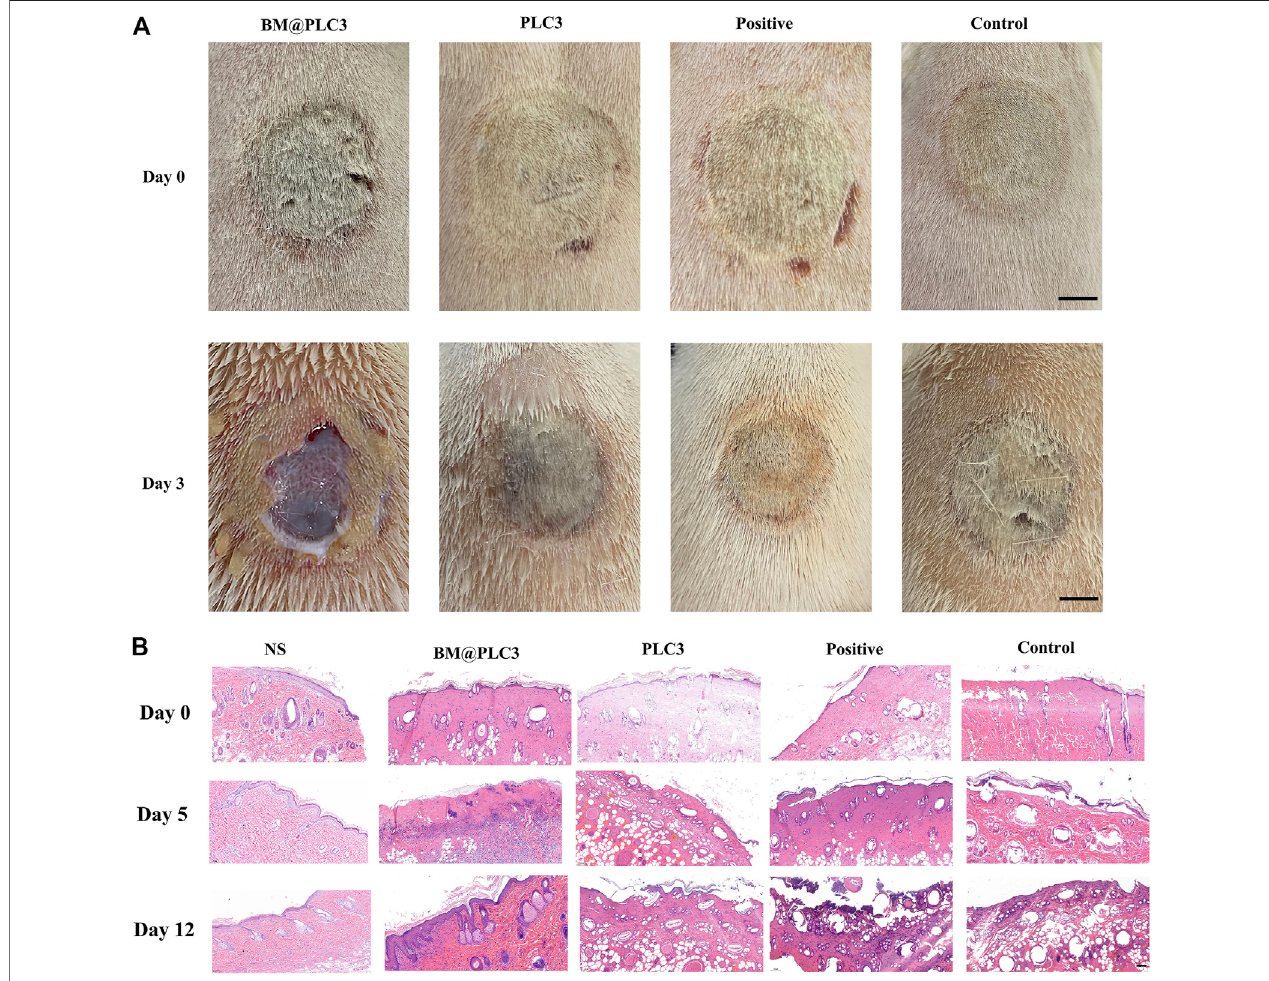
FIGURE 9 | The result of burn magni fi cation test. (A) The image of burn wound before treatment on days 0 and 3, scale bar: 1 cm. (B) H&E staining on the normal skin group (NS), BM@PLC3 group, PLC3 group, positive group, and control group on days 0, 5, and 12; scale bar: 100 μ m.